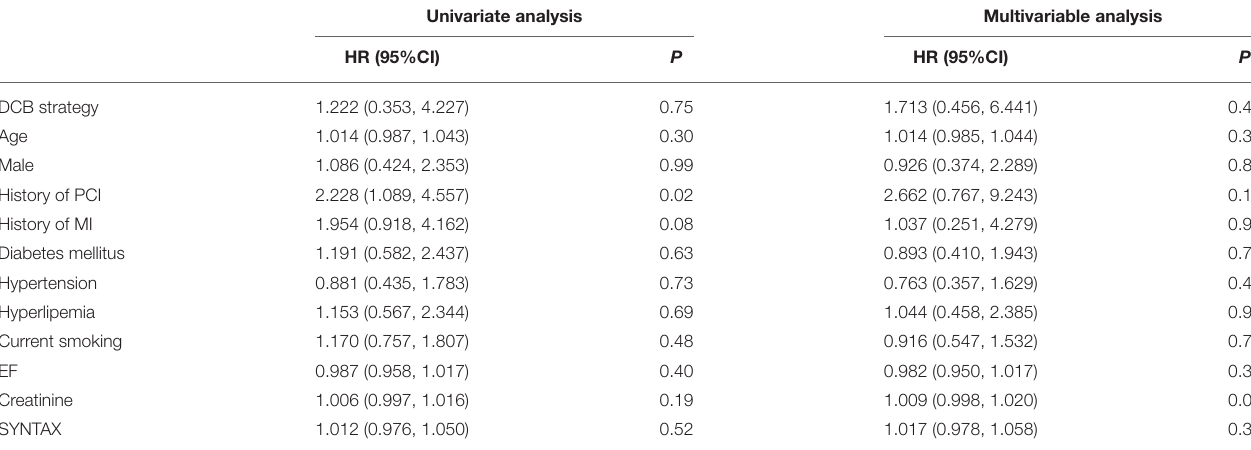
TABLE 4 | Cox proportional hazard regression analyses for major adverse cardiovascular events. Univariate